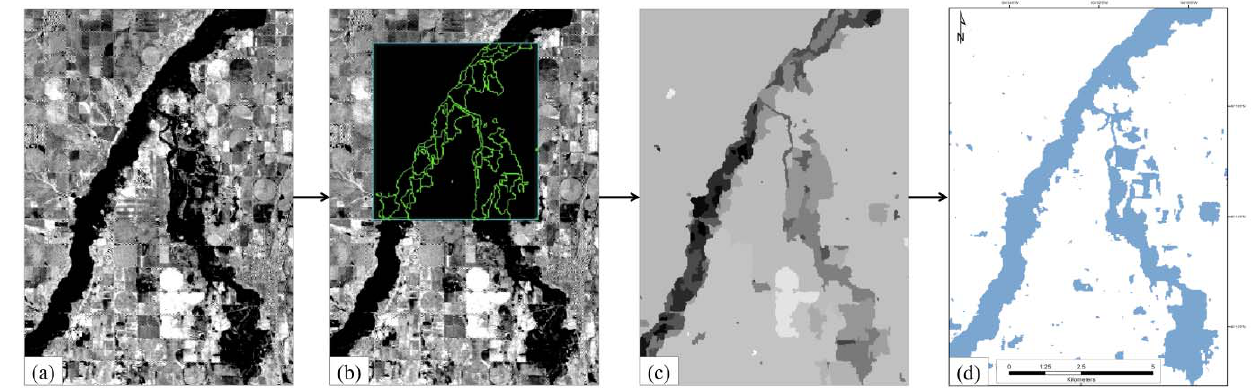
Figure 3. General steps of the segmentation procedure used to extract flood features from IC3. The confluence of the Saint Vrain and South Platte Rivers is shown as an example. ( a ) IC3 change values shown in gray scale. ( b ) Flooded pixels isolated with edge filter. ( c ) Segmented image objects ( d ) Extracted ICA flood layer, merged with pre-existing water-to-water pixels ( i.e. , river channels and